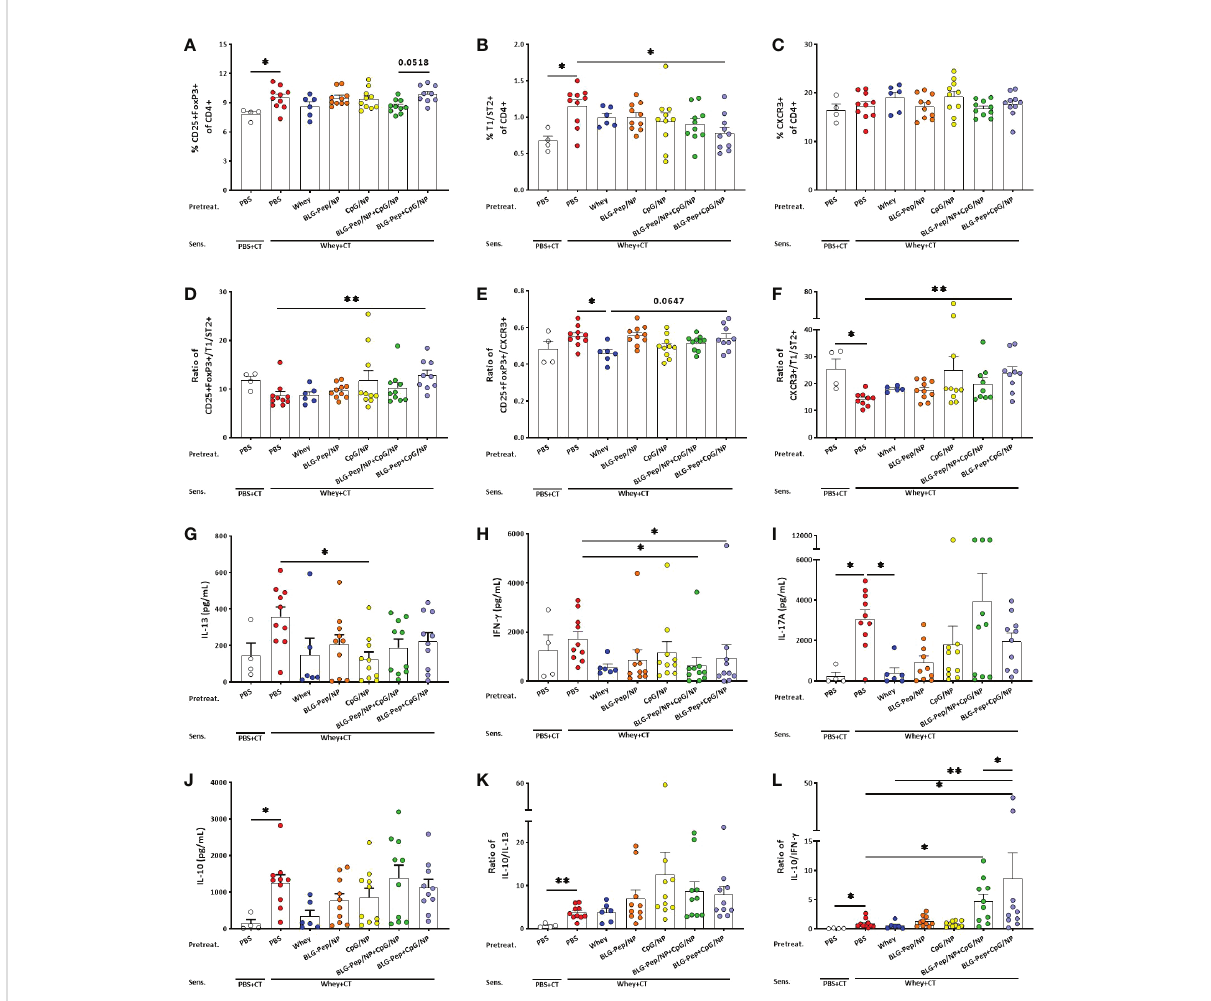
FIGURE 5 Splenic T-cell subsets and cytokines production of splenocytes upon ex vivo stimulation with whey for 5 days. Eighteen hours after the last oral challenge with whey, splenocytes were isolated and analyzed by fl ow cytometry for the percentages of T-cell subsets including Treg (A) , Th2 (B) , Th1 (C) , ratio of Treg/Th2 (D) , ratio of Treg/Th1 (E) and ratio of Th1/Th2 (F) respectively. Splenocytes were restimulated with whole whey protein for 5 days, Th2- (G) , Th1- (H) , Th17- (I) , and Treg- (J) associated cytokines were measured in supernatants. Ratios of Treg-/Th2- associated (K) and Treg-/Th1-associated (L) cytokines were calculated. (F, I, K, L) are presented with Y axis formatted in two segments to be able to appreciate the full data set. Data are presented as mean ± SEM for n=9-10 per group except for the sham group, n=4 and whey-tolerant group, n=6. (A – C) and (E) are analyzed with one-way ANOVA for selected pairs, followed by Bonferroni ’ s post hoc test; (D) and (F – K) are analyzed with the Kruskal-Wallis non-parametric test, followed by Dunn ’ s post hoc test for selected pairs; (L) is analyzed with one-way ANOVA for selected pairs after log transformation, followed by Bonferroni ’ s post hoc test; * p <0.05, ** p <0.01; CT, Cholera